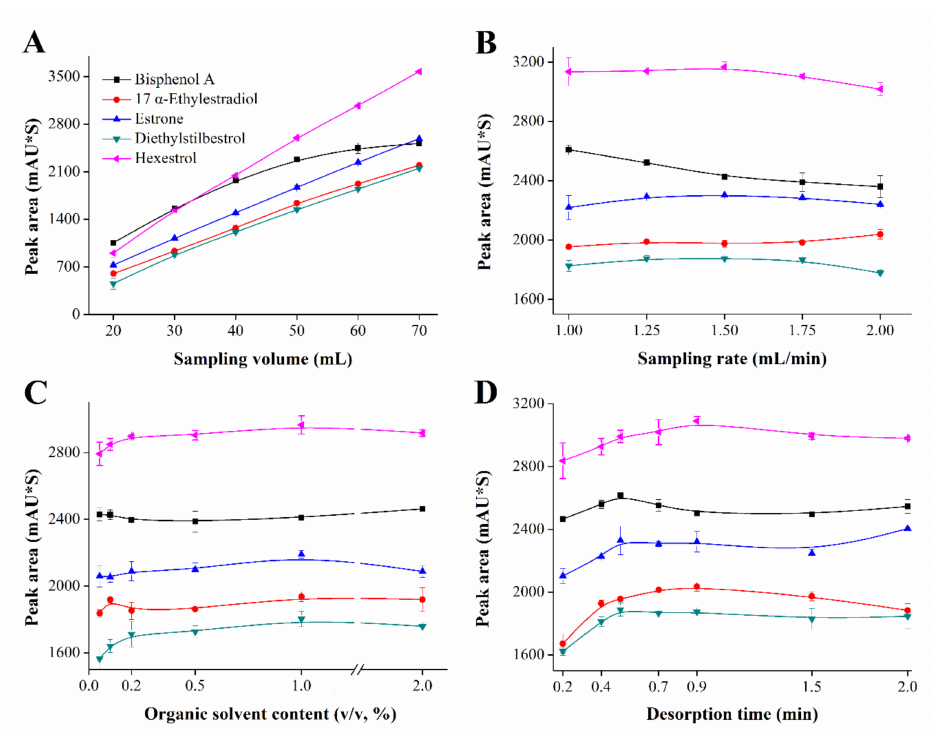
Figure5. Theimagesofextractionconditionsoptimizationincluding( A )samplingvolume, ( B )sampling rate, ( C ) organic solvent content and ( D ) desorption time. Conditions: concentration of estrogens, 5 µ g / L. The number of experiments to establish the plotted values was three ( n =